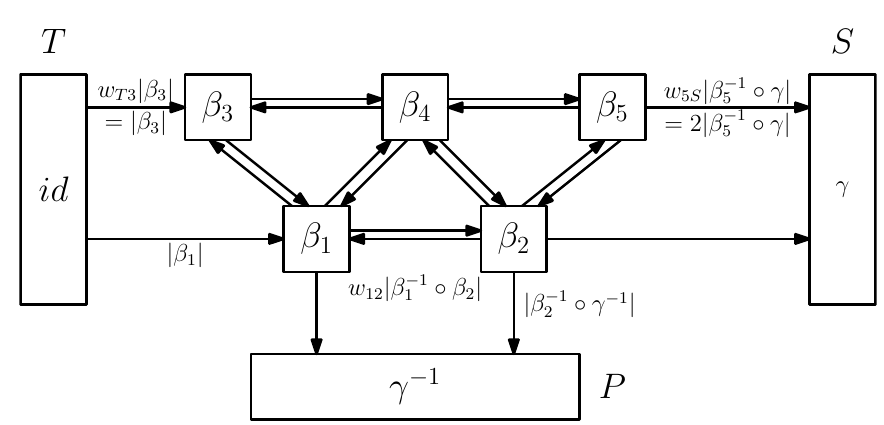
Figure 20 . The flow network associated to a tensor network.